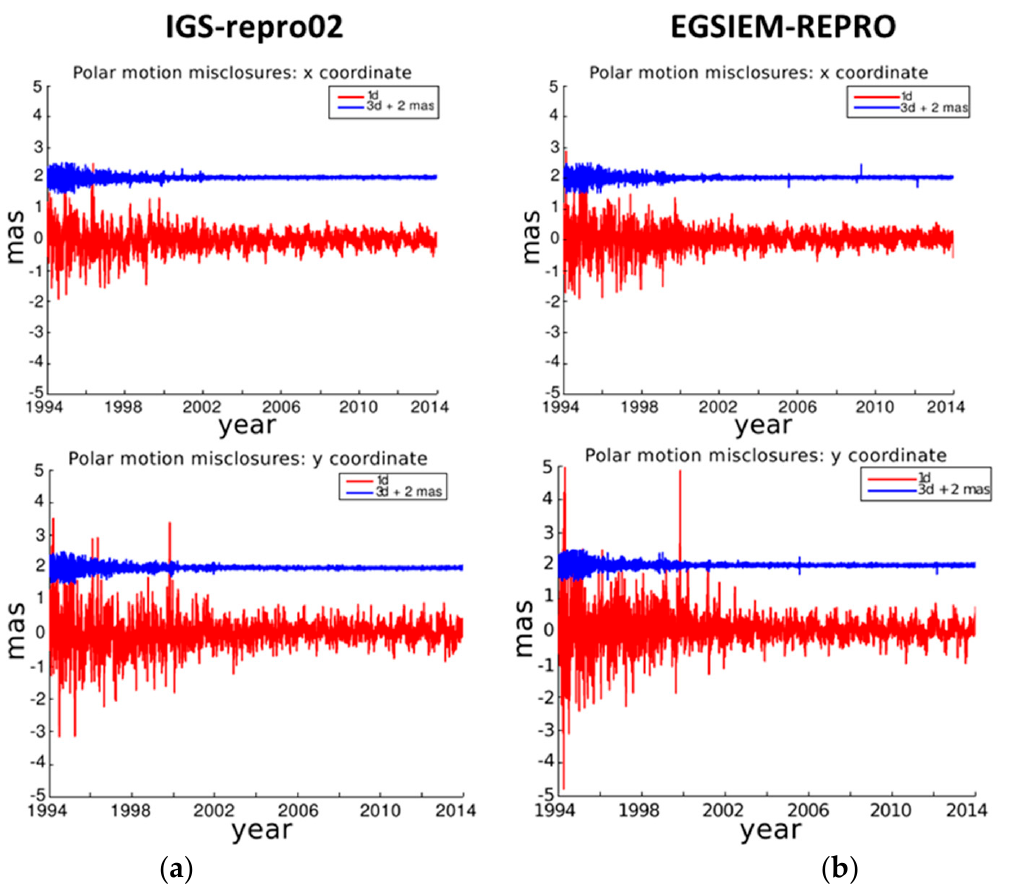
Figure 4. ( a ) Time series of polar motion misclosures referring to the 2nd IGS reprocessing campaign (IGS-repro02). ( b ) Time series of polar misclosures referring to the reprocessing campaign carried out in the frame of the EGSIEM project (EGSIEM-REPRO). The top shows misclosures in the x coordinates and the bottom shows misclosures in the y coordinates, plotted with a shift along the vertical axis for clarity. Polar motion misclosures referring to the 1-day solution are shown with red, while polar motion misclosures referring to the 3-day solution are presented in blue.